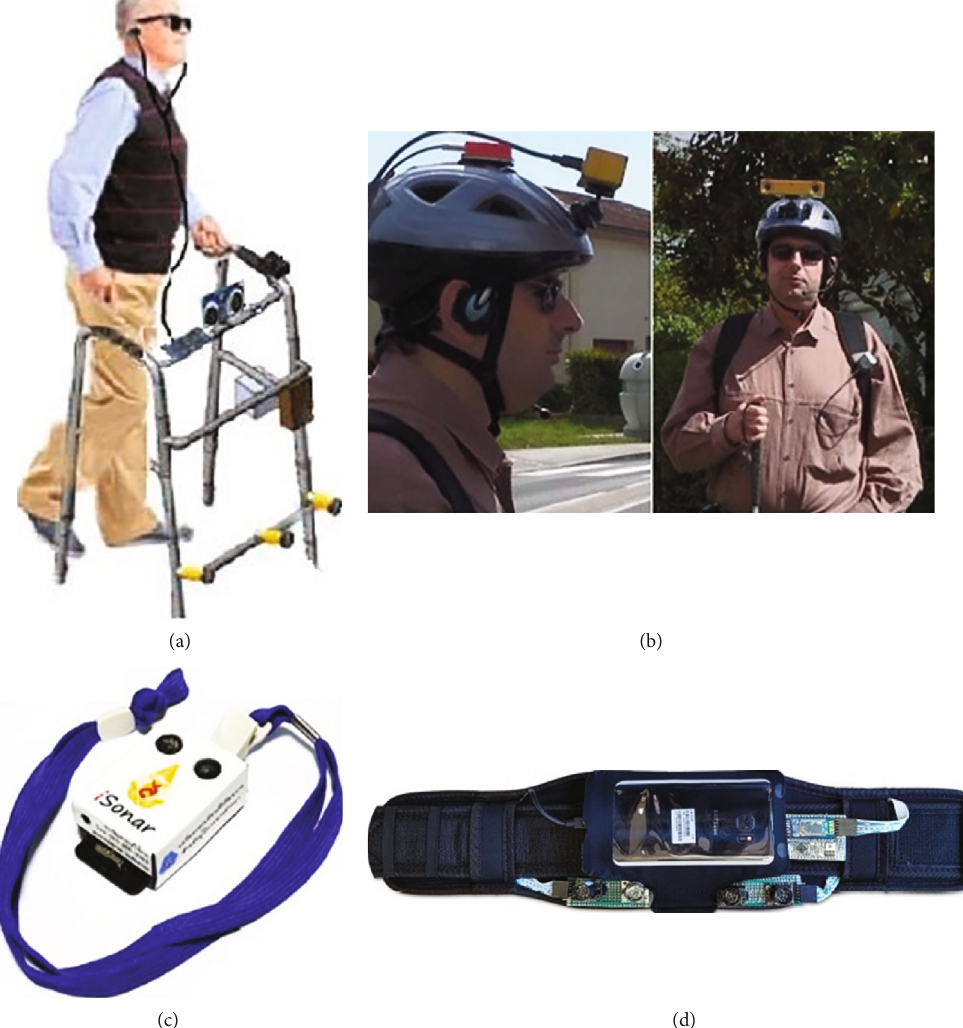
Figure 1: Di ff erent mobility assistive devices for visually impaired people: (a) [18], (b) [11], (c) [15], and (d)